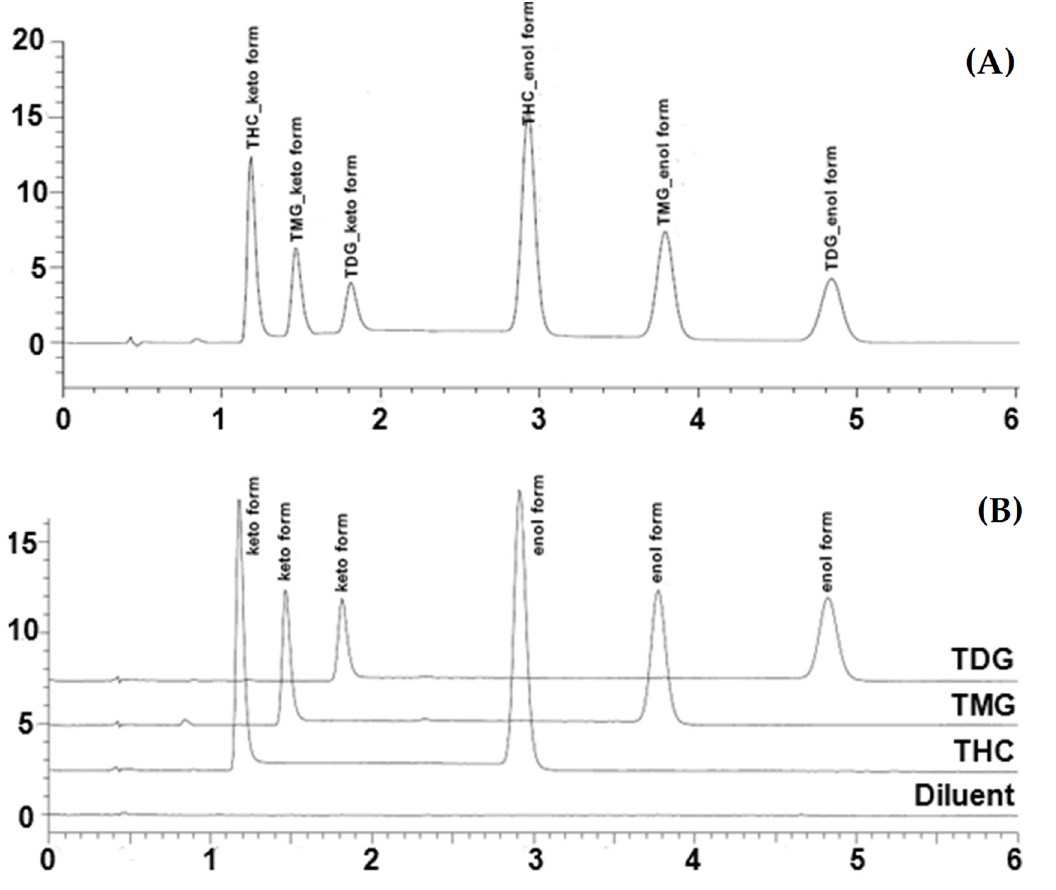
Figure 2. ( A ) The chromatogram of system suitability containing 10 µ g/mL of THC, TMG, and TDG and ( B ) overlaid chromatograms of diluent, THC, and TDG standard solutions.